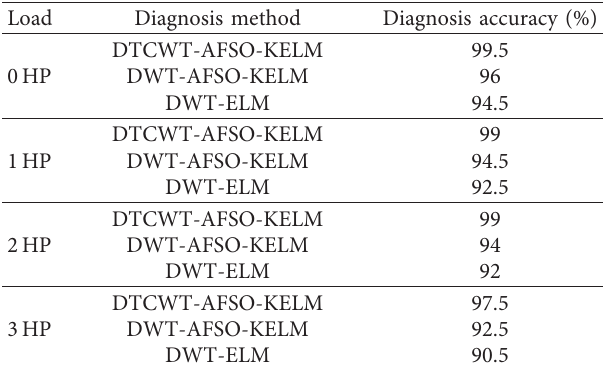
Figure 4: The diagnosis results of DTCWT-AFSO-KELM, DWT- AFSO-KELM, and DWT-ELM under different load conditions. Table 1: The diagnosis accuracies of DTCWT-AFSO-KELM, DWT-AFSO-KELM, and DWT-ELM under different load